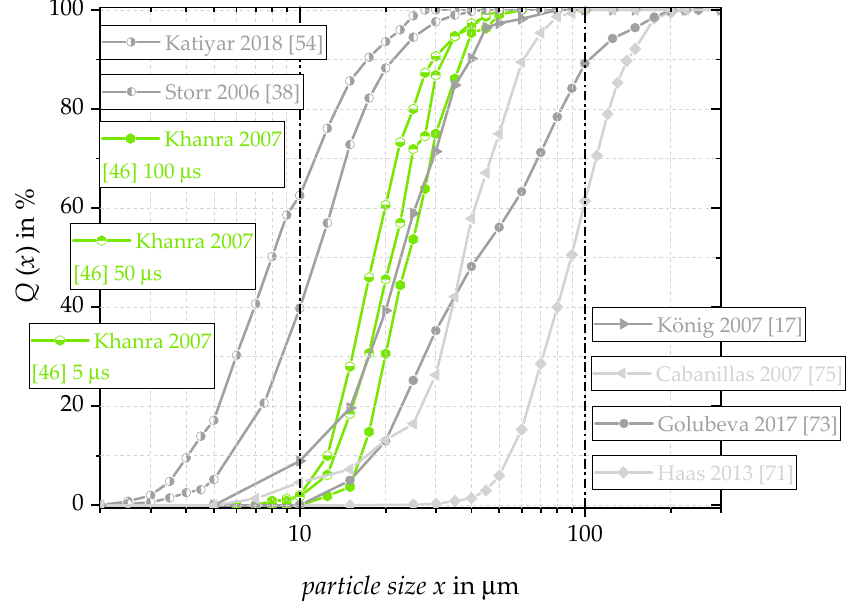
Figure 2. Particle size distributions for selected references gained from ImageJ analysis. Data from [17,38,46,54,71,73,75].